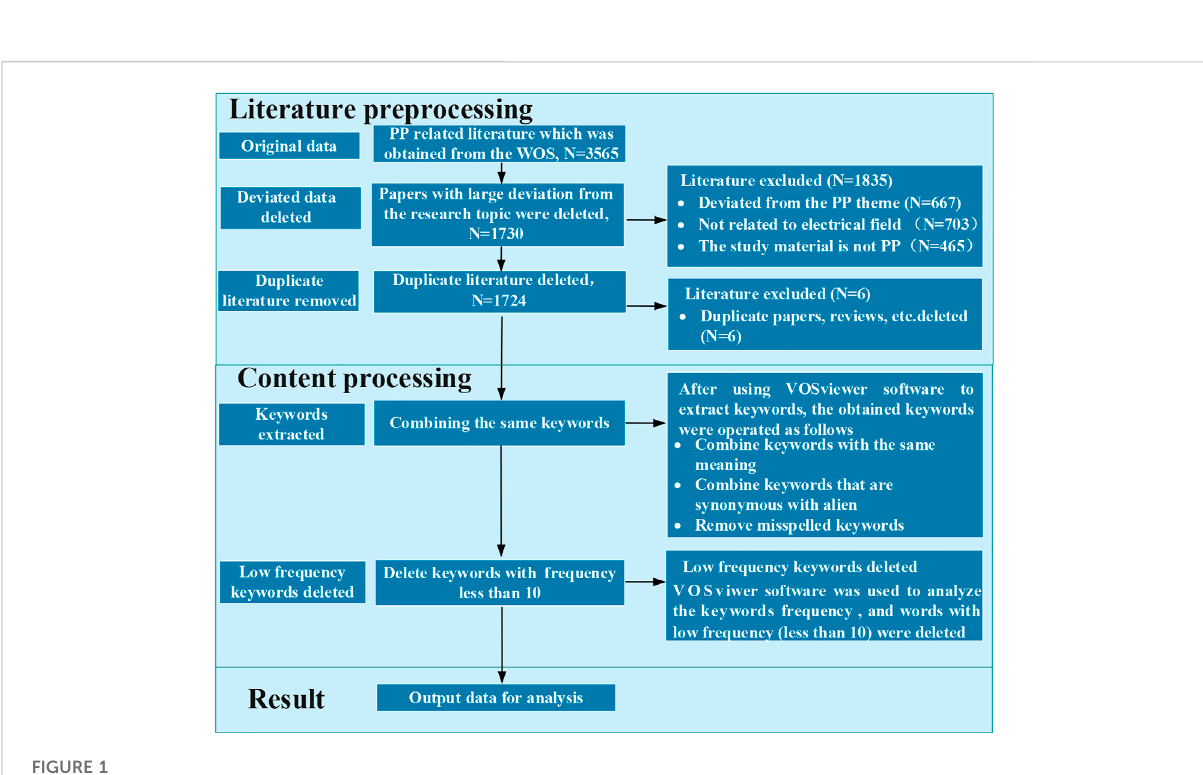
FIGURE 1 Process of data